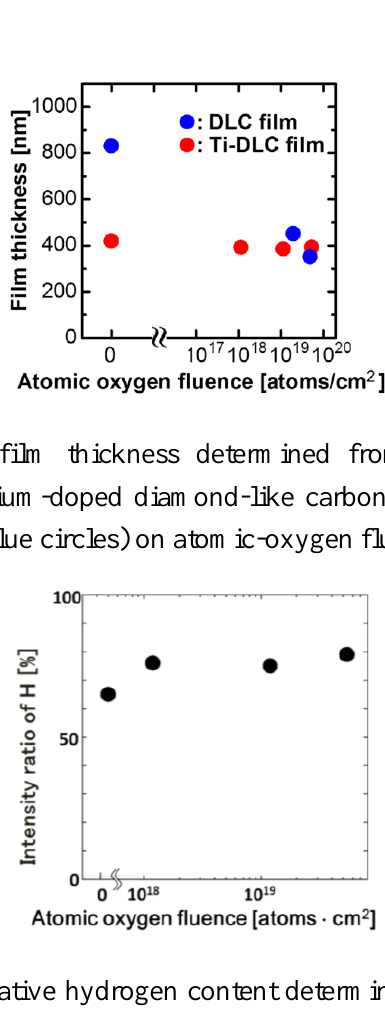
Figure 2. Dependence of relative hydrogen content determined from combination of